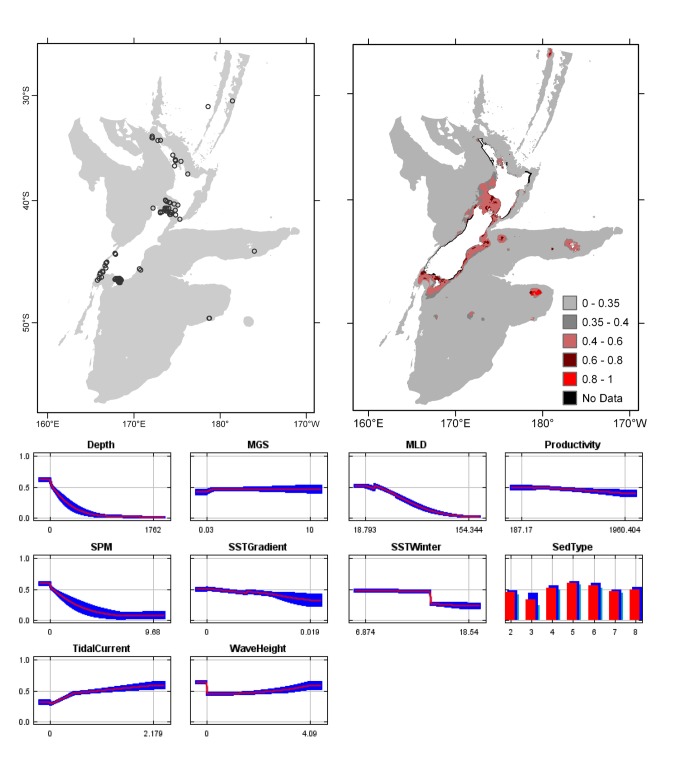

Arachnopusia

unicornis
 known distribution (left), predicted suitable habitat (right), and fitted responses curves (marginal).For the predicted distribution, logistic probabilities less than the 10th percentile presence value indicated cells were unsuitable habitat. Probabilities of 0.4–0.6 indicated habitat suitability typical of the presence records, values of 0.6–0.8 and 0.8–1 indicated favourable and highly suitable habitat, respectively. Black cells had missing data in one or more environmental layer. Independent records are layed over the predictions. Marginal response curves show how the prediction changes for different values of each variable when all other variables were at their average sample value. Individual response curves are shown in Figure S3. For the categorical variable Sediment type: 1 = deep ocean clays; 2 = calcareous gravel; 3 = volcanic; 4 = calcareous mud; 5 = gravel; 6 = mud; 7 = sand; 8 = calcareous sand.